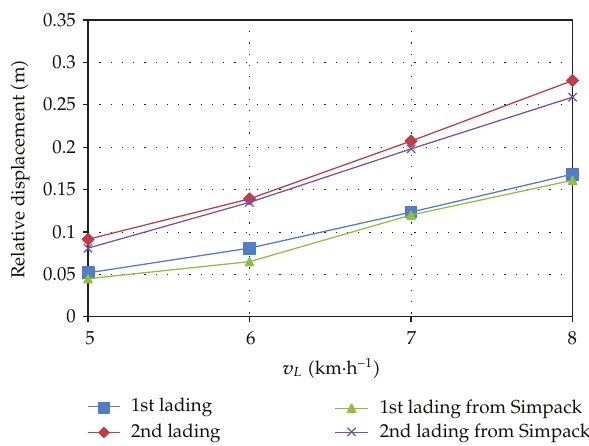
Figure 6: Results under m 1 (cid:10) 30t, m 2 (cid:10) 30t, μ 1 (cid:10) 0 . 4, and μ 2 (cid:10) 0 . 3.